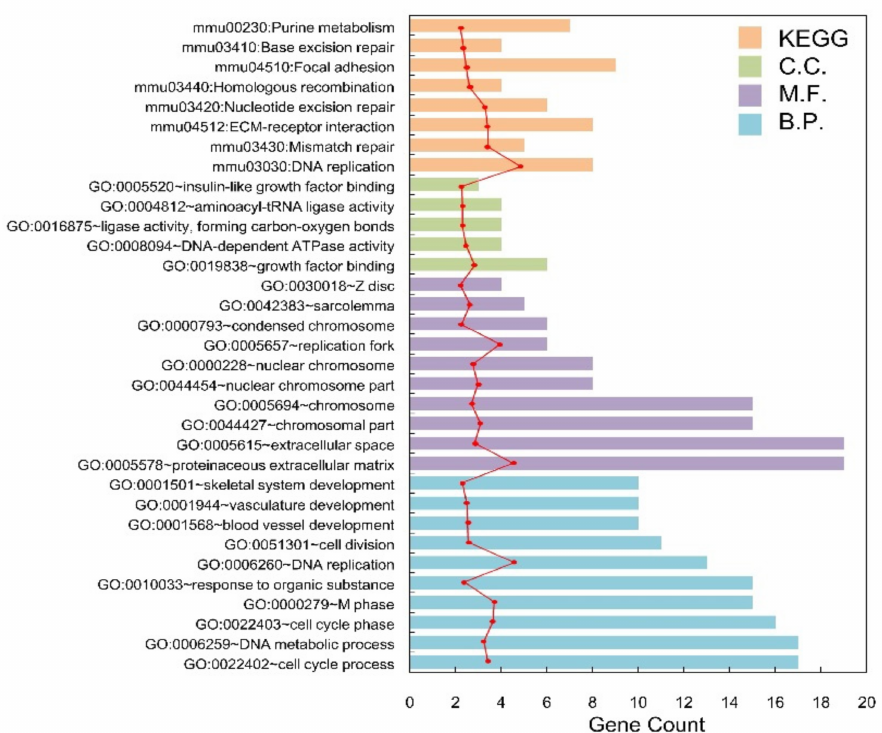
Figure 3. The histogram of the category of enriched GO terms and KEGG pathways for the overlapped DEGs. The horizontal axis represents the number of blue, purple, green, and orange mean Biology Process, Cellular Component, Molecular Function, and pathways, respectively; the red dot curve means –log10 ( p -value). Table 2. Correlation between physiological phenotypes and each module genes. Color Gene